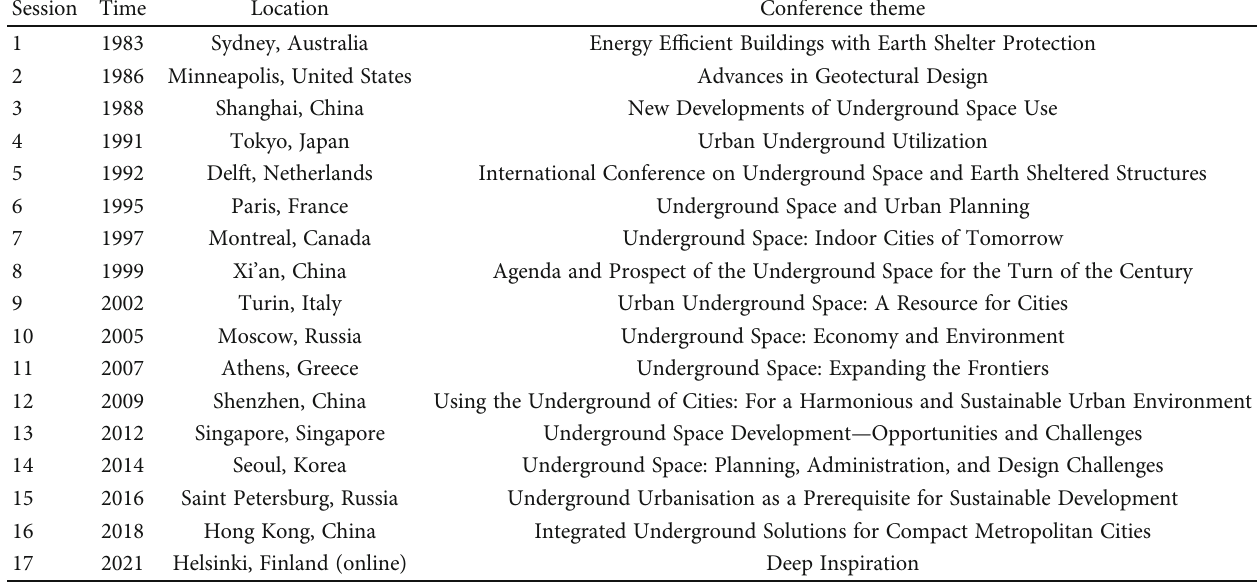
Table 1: Past conferences of